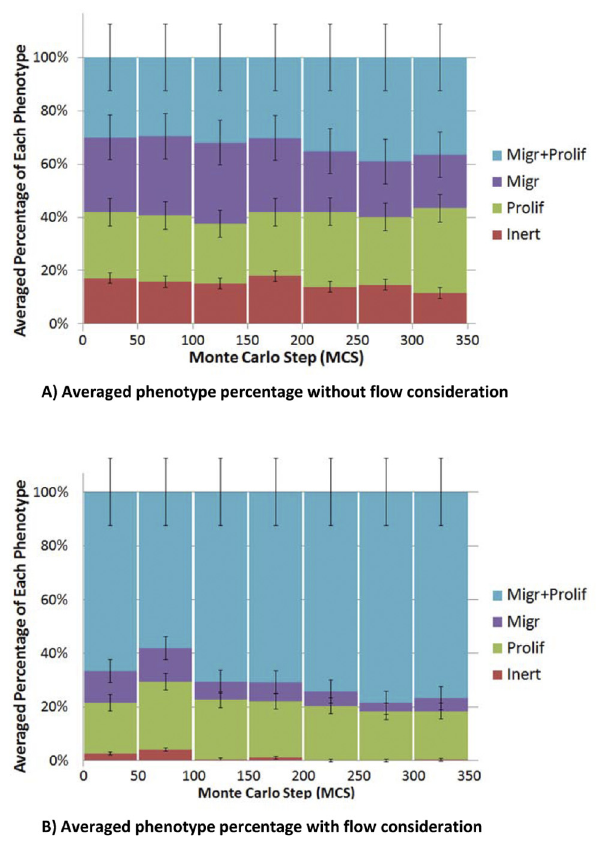
Fig 17. Stacked area diagram for portion of each phenotype in the loop during the solution. A) The case without flow which leads to loop collapse. B) The case with flow which leads to loop